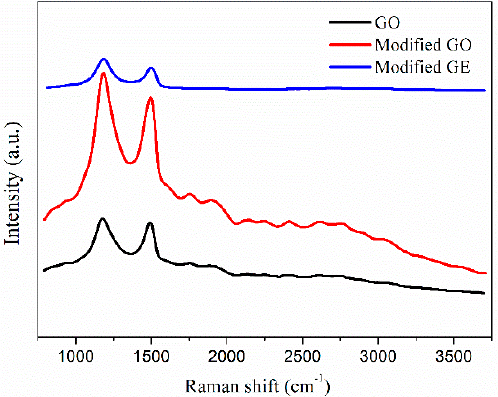
Figure 2. Raman spectra of GO, modified GO, and modified GE.